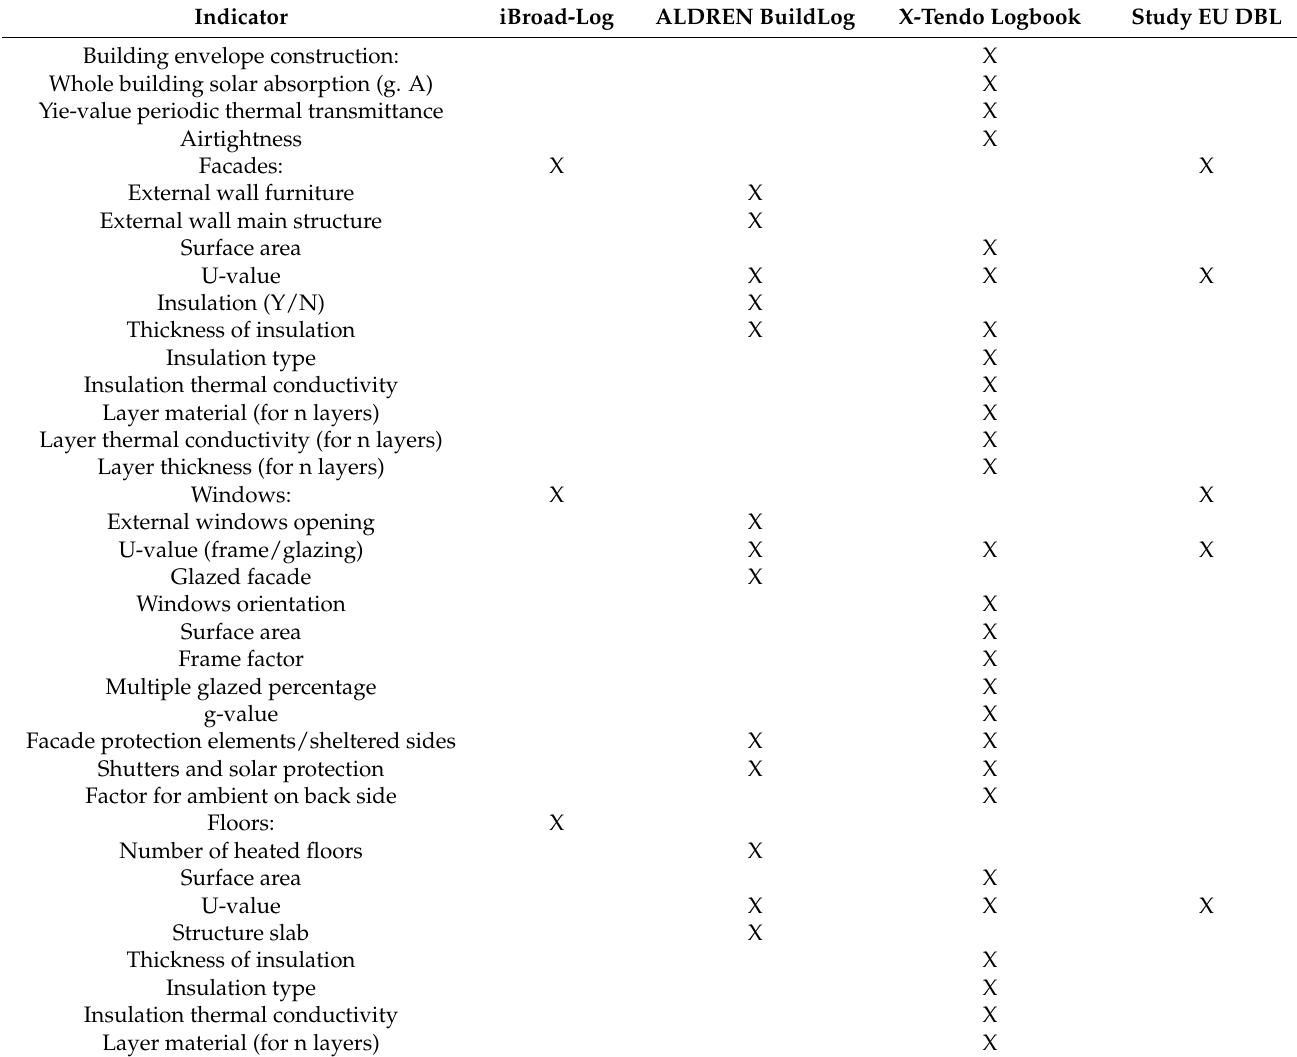
Table A2. Module 2: construction information and